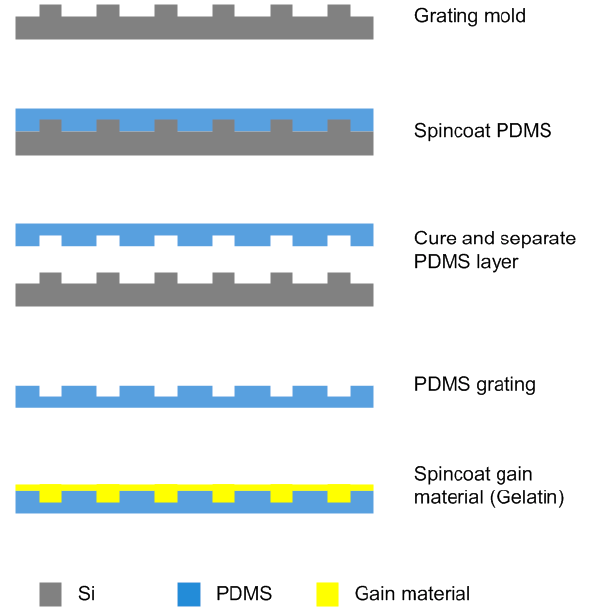
Figure 2. The schematic fabrication process of the tunable DFB film dye laser device.